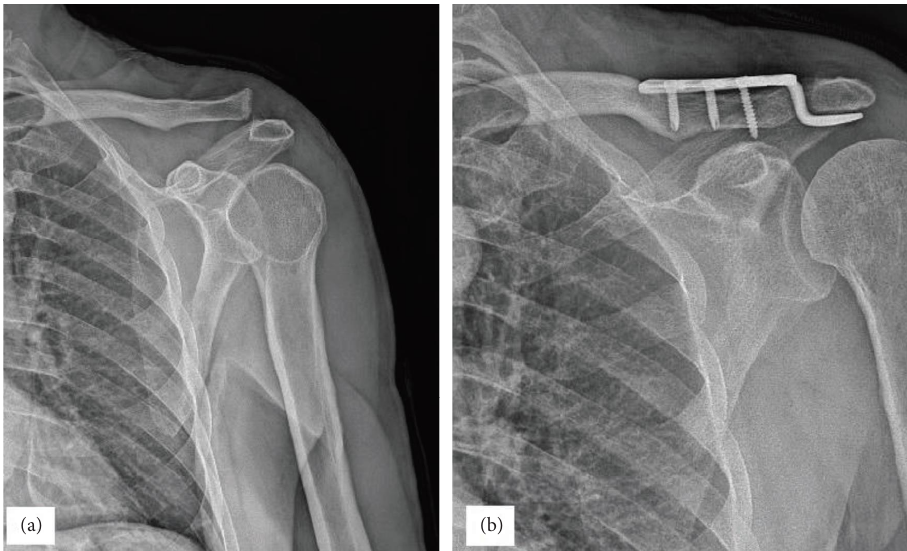
Figure 2: (a) Te preoperative anterior and posterior view of a 32-year-old male patient with Rockwood type III acromioclavicular joint dislocation after a motorcycle accident injury. (b) 6-month postoperative plain radiograph showing good maintenance of joint reduction with hook plate fxation.